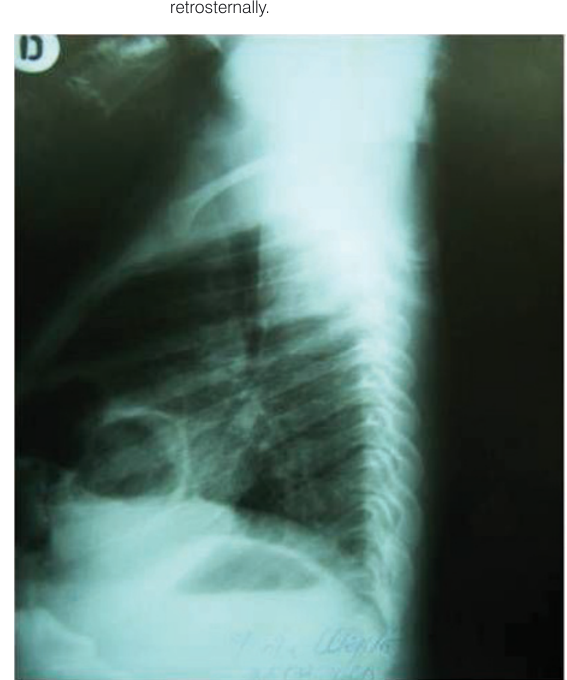
Figure 1. Standard chest radiography with bowel loops in the right hemithorax.